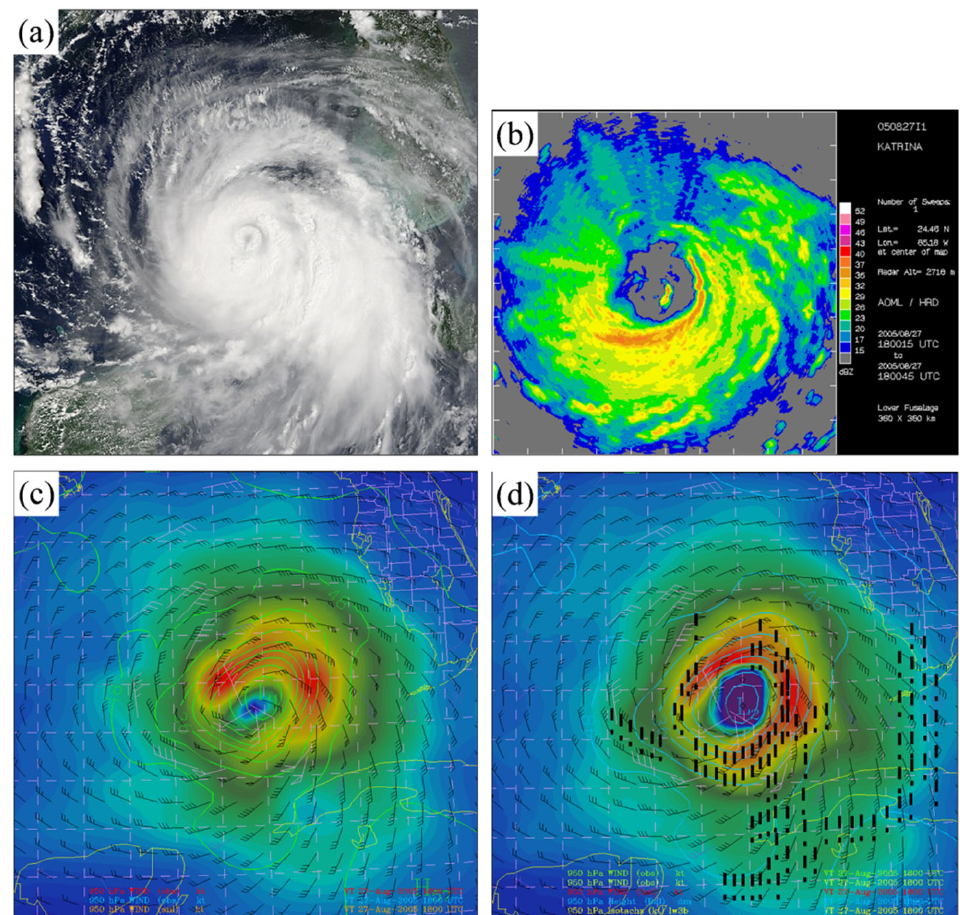
Figure 5. Horizontal distribution of the observed (upper panels) and analyzed (lower panels) Hurricane Katrina. ( a , b ) are the satellite visible (19:25 August 2017) and reflectivity imagery (18:15 to 18:25 27 August), respectively. ( c , d ) are the analyzed wind speed (shaded area) and direction (wind barbs) under imbalanced and balanced conditions obtained for 18:00 27 August using he Hurricane Local Analysis Prediction System (HLAPS), respectively. Blue (white) to red (bright white) color indicates the strengthened wind speed (intensified cloudiness). Dashed lines in ( d ) present the intensified wind-speed zone compared to those in ( c ).